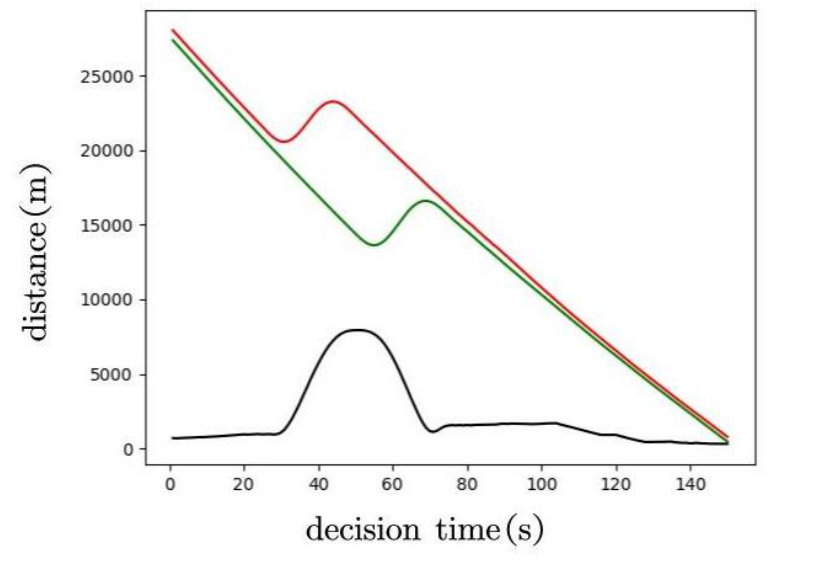
Figure 6. Change of the distance in the process of air